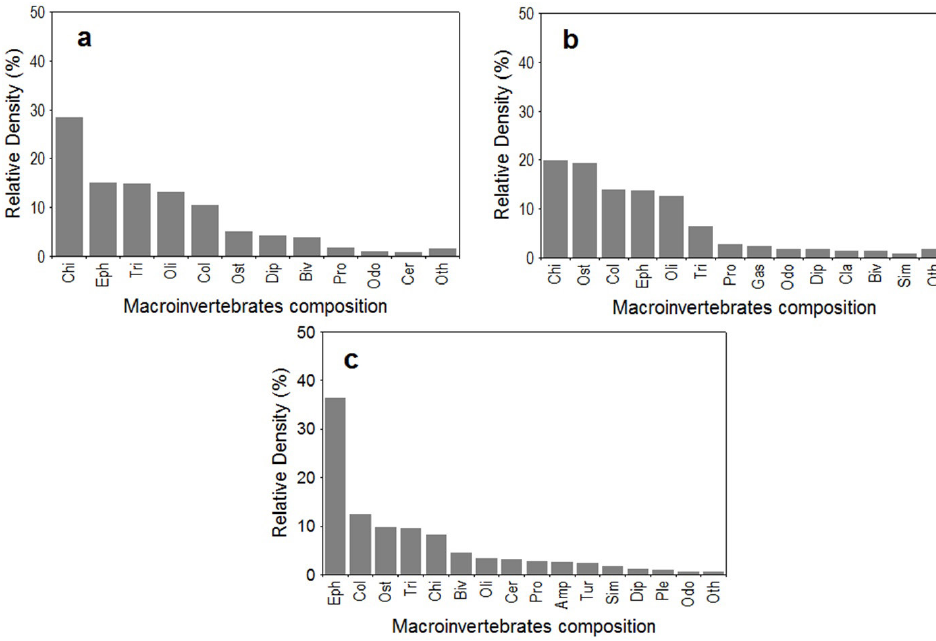
Figure 4. Relative abundance of aquatic macroinvertebrates sampled in Água Queçaba stream (a), Remo stream (b) and Zaúna stream (c). Chi= Chironomidae; Cer= Ceratopogonidae; Sim= Simuliidae; Dip= Diptera; Eph= Ephemeroptera; Tri= Trichoptera; Col= Coleoptera; Ple= Plecoptera; Odo= Odonata; Oli= Oligochaeta; Ost= Ostracoda; Amp= Amphipoda; Biv= Bivalvia; Pro= Prostigmata; Tur= Turbellaria; Cla= Cladocera; Gas= Gastropoda; Oth= others invertebrates. Table 3. Results of Spearman correlation ( R ) between abundance of prey in the environment and diet of fish species sampled in three streams located in the Pirapó River sub-basin (Paraná River, Brazil).